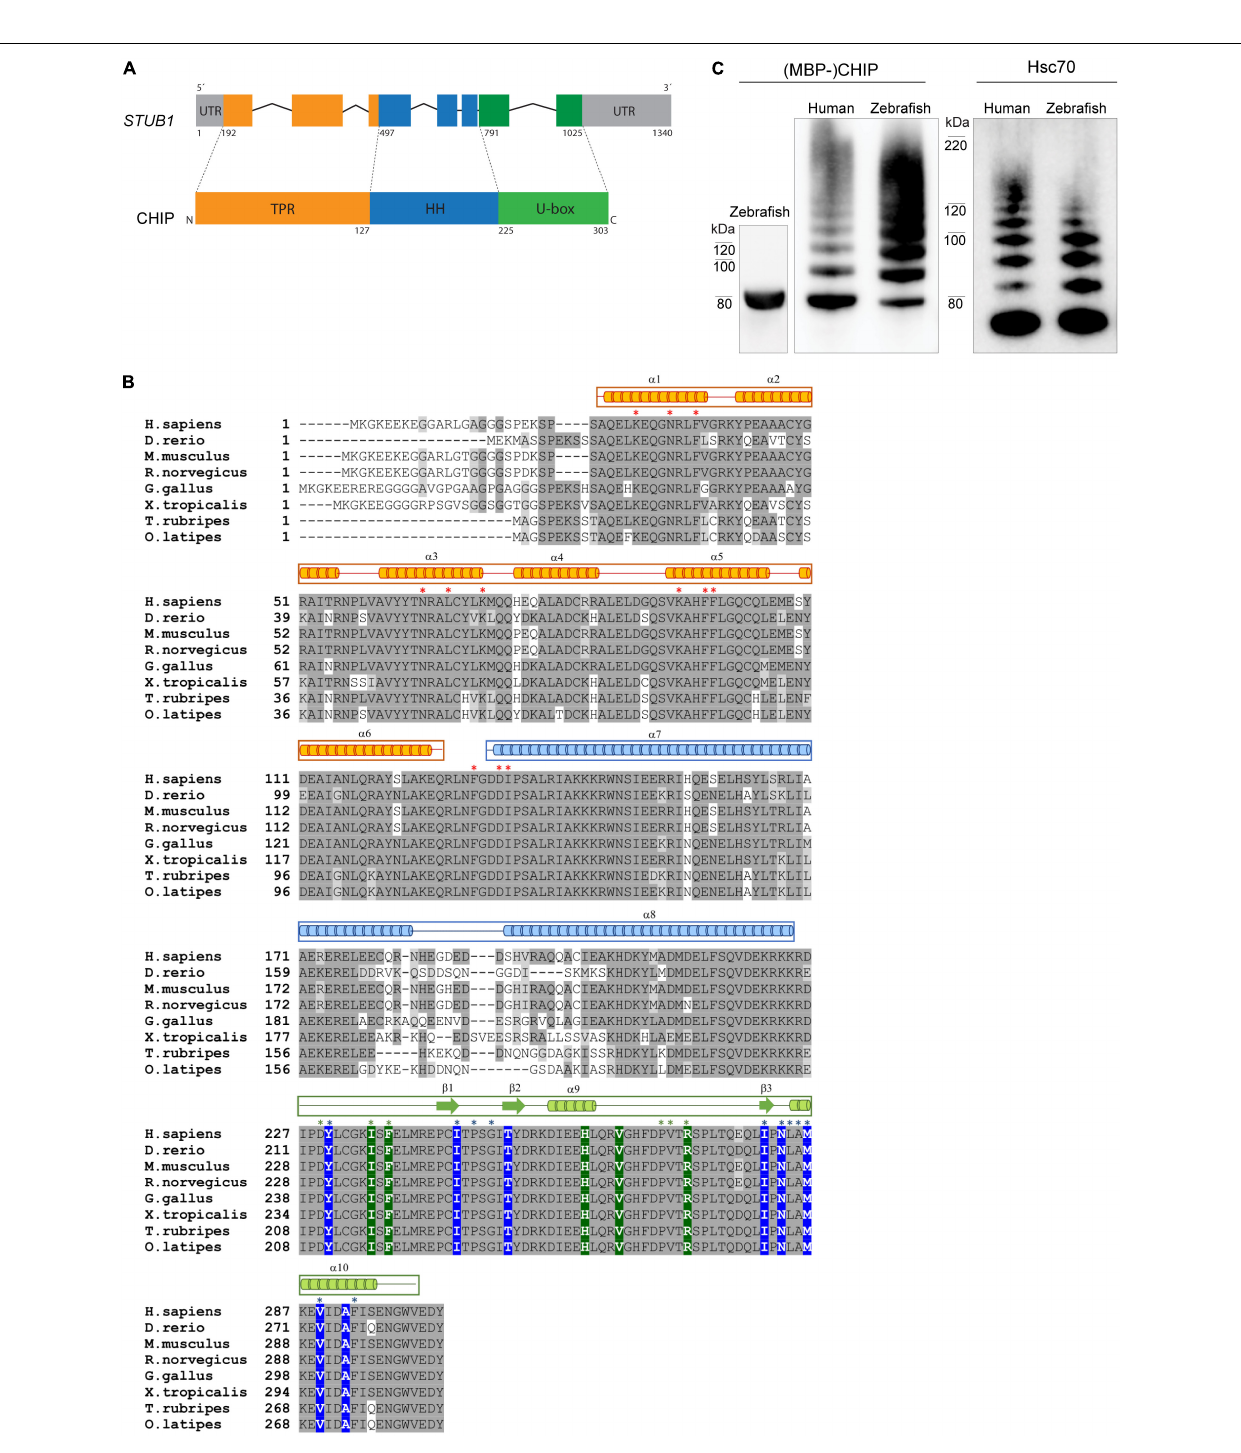
FIGURE 1 | CHIP structure and ubiquitination activity is conserved among human and zebrafish. (A) Seven exons in the structure of STUB1 gene correspond to the TPR, helical hairpin, and U-box domains of CHIP protein. (B) Alignment of CHIP sequence from human ( H. sapiens ), zebrafish ( D. rerio ), mouse ( M. musculus ), rat ( R. norvegicus ), chicken ( G. gallus ), frog ( X. tropicalis ), pufferfish ( T. rubripes ), and Japanese rice fish ( O. latipes ). The predicted position of secondary structures is displayed above the corresponding amino acid sequences in orange, blue, and green boxes corresponding to the TPR, helical hairpin, and U-box domains, respectively. Main residues involved in the U-box dimerization (in blue) as well as interactions via the TPR (in orange) and U-box (in green) domains are marked with background color (reported in zebrafish Chip) and/or asterisks (reported in mouse CHIP). This figure was produced by using T-Coffee (Notredame et al., 2000). (C) MBP-Chip recombinant protein was detected by Western blot analysis around 80 kDa (lane 1). Identical Hsc70- and self-ubiquitination activities were observed for human CHIP (lanes 2 and 4) and zebrafish Chip (lanes 3 and 5), shown by multiple ubiquitinated bands above MBP-CHIP (lanes 2 and 3) and Hsc70 (lanes 4 and